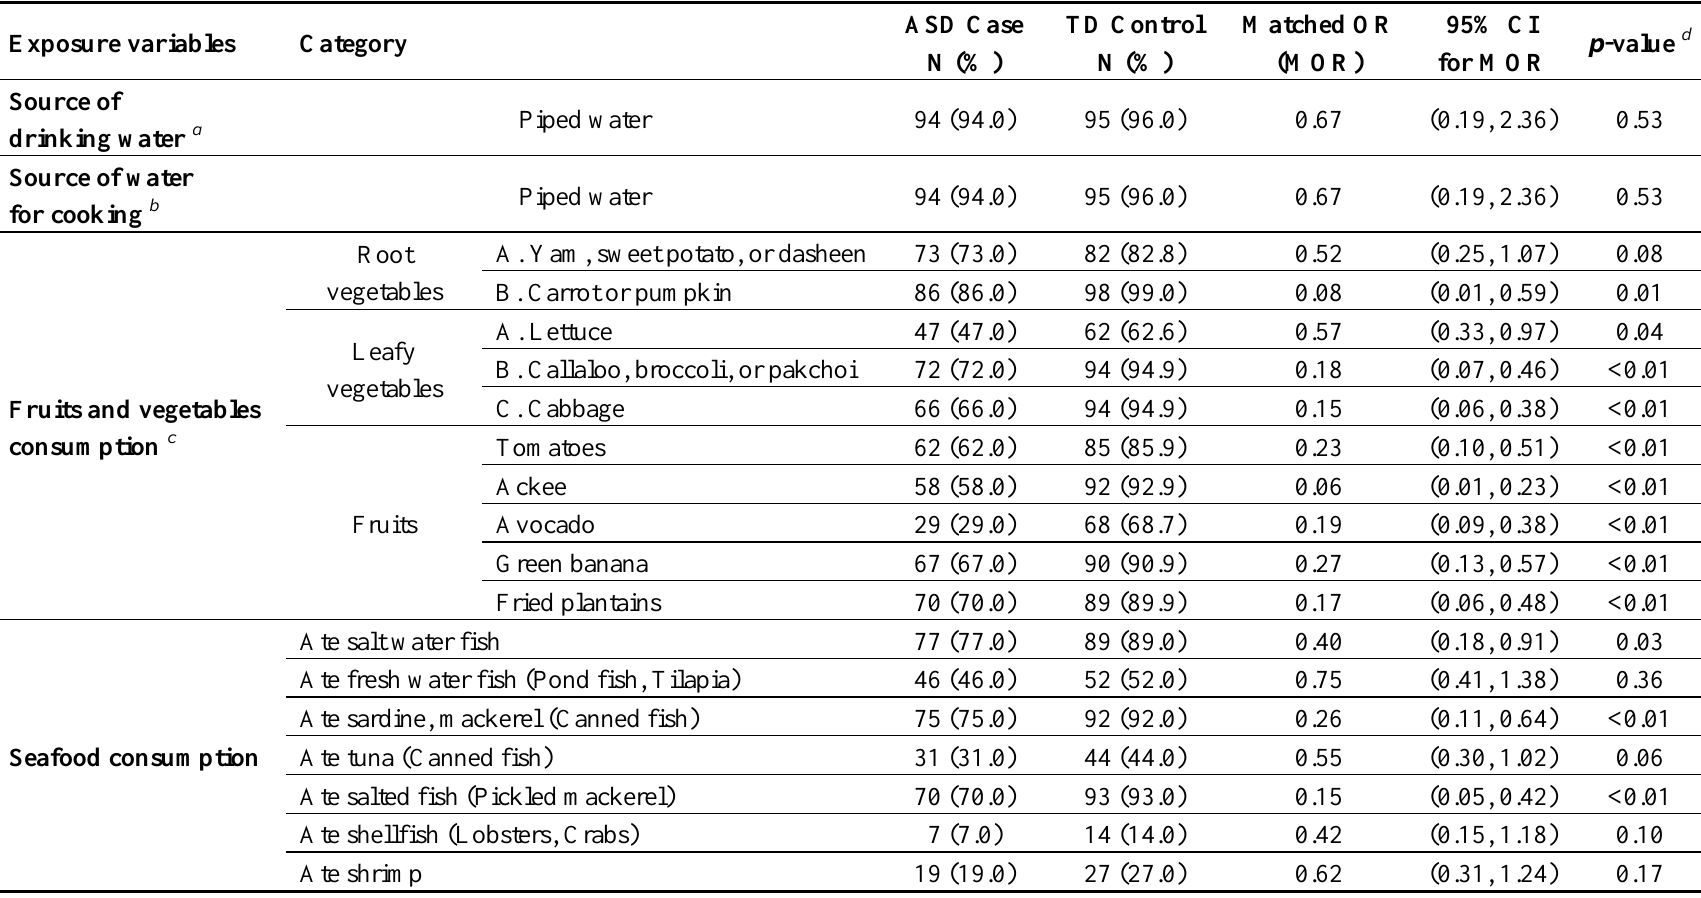
Table 2. Associations between dietary consumption and ASD case status using Conditional Logistic Regression (CLR) (200 children or 100 matched